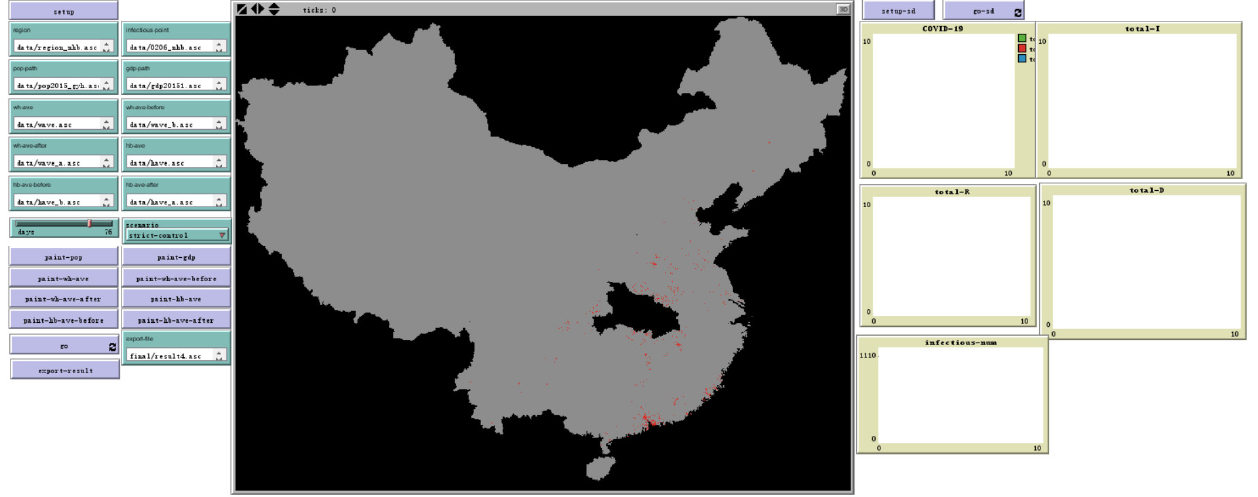
Figure 4. Spatiotemporal dynamics pandemic model (SDPM) user interface.